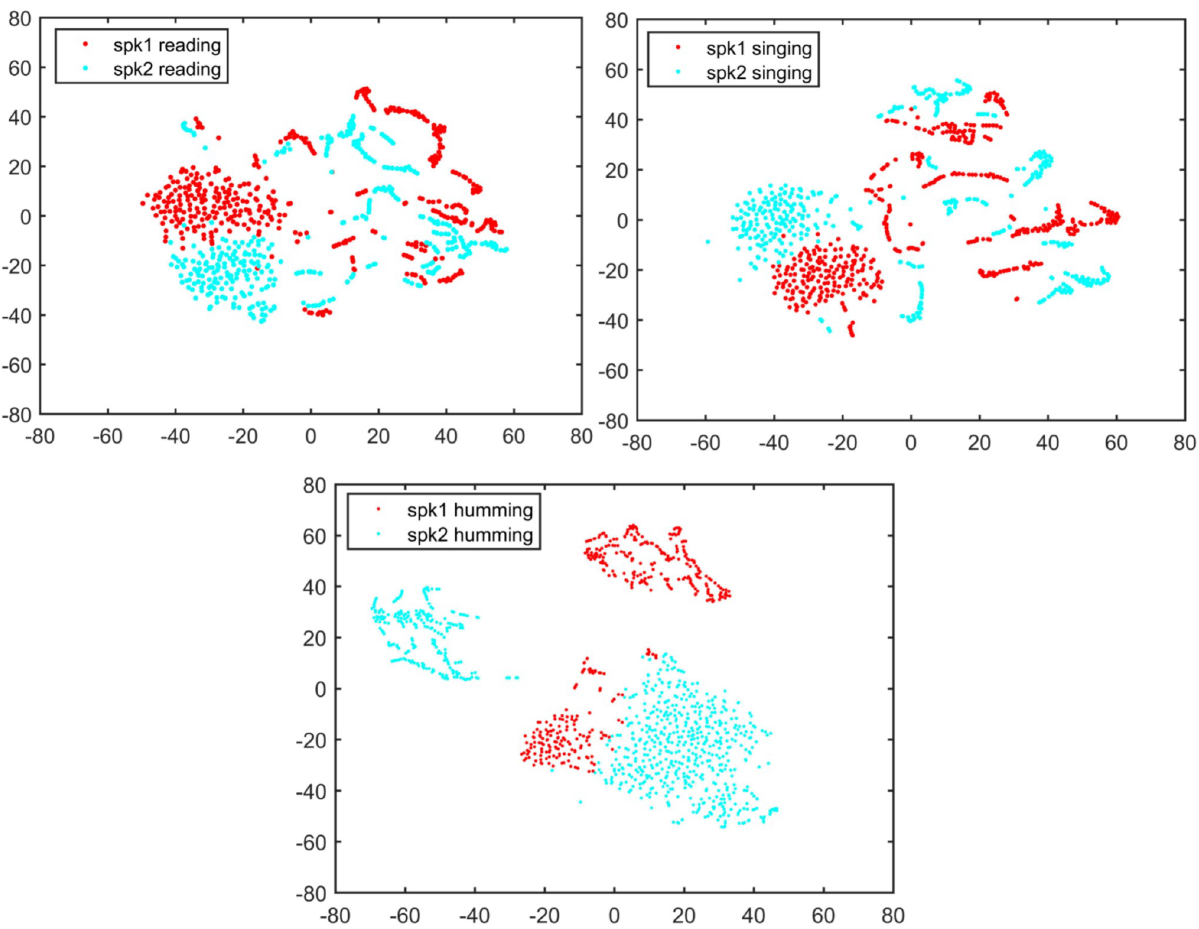
Fig 2. Two speaker’s feature space discrimination using t-SNE for each speaking style under text-dependent condition.